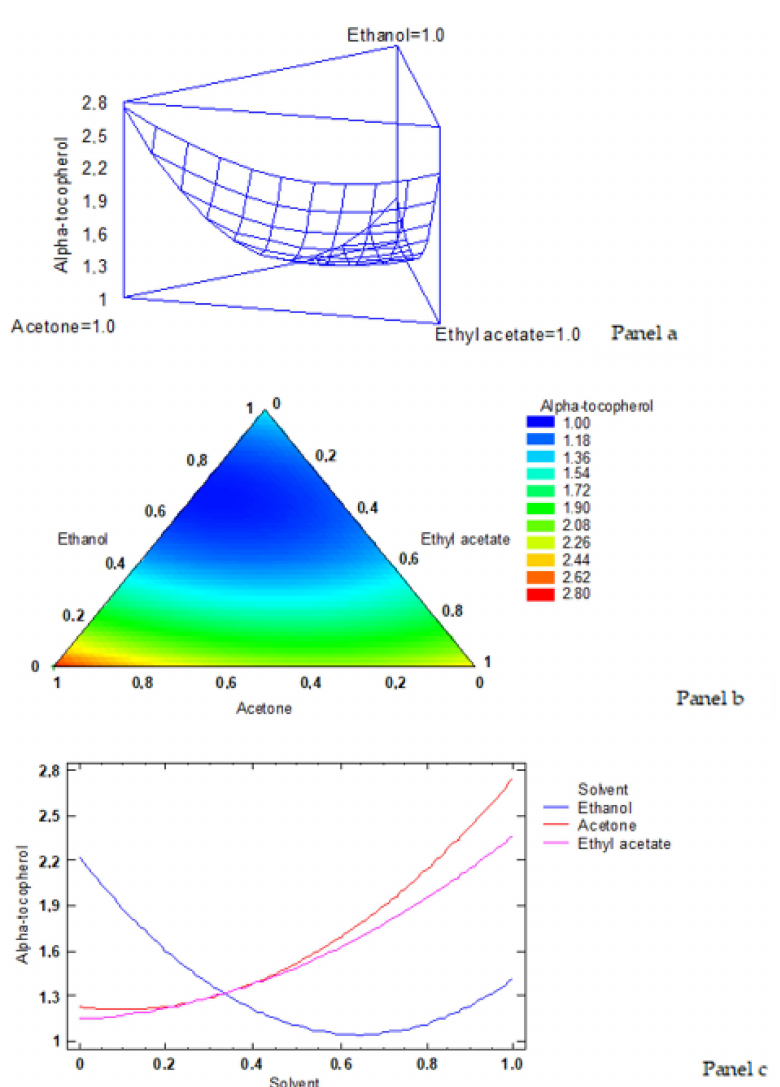
Figure 2. Application of the simplex-lattice design on the fitting model corresponding to the α -tocopherol content (g · kg − 1 lipids). Panel a : estimated response surface; Panel b : contours of estimated response surface; Panel c : trace plot for α -tocopherol